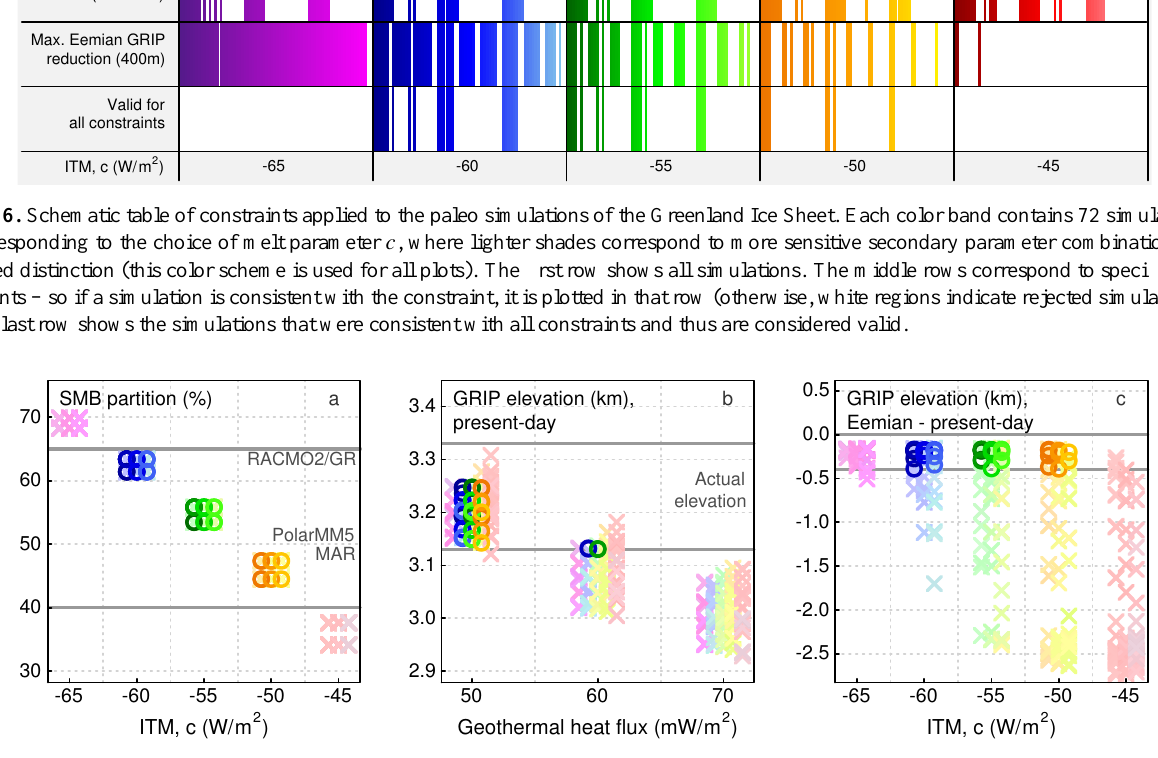
Fig. 7. Ensemble results for the three constraints versus the most influential parameter in each case: (a) diagnosed SMB partition for the present-day GIS, compared to results from regional climate models (PolarMM5: Box et al., 2006; MAR: Fettweis et al., 2007; RACMO2/GR: Ettema et al., 2009); (b) simulated present-day GRIP elevation versus the prescribed geothermal heat flux at the base of the ice sheet; (c) maximum reduction in the modeled GRIP elevation for the Eemian Interglacial relative to the modeled present-day elevation. Darker circles and lighter crosses correspond to “valid” and “invalid” simulations, respectively, and the grey lines show the outer limits used for each